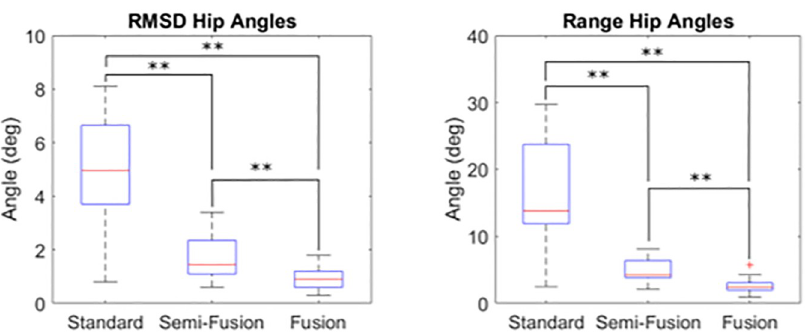
Fig 7. Overview of the differences of variability for the hip angles with the standard method, the semi-fusion method, and the fusion method. ( �� for p < 0.01). https://doi.org/10.1371/journal.pone.0226648.g007 Table 3. Variability of the hip joint angles, all results are in degree. a. Vertical Offset